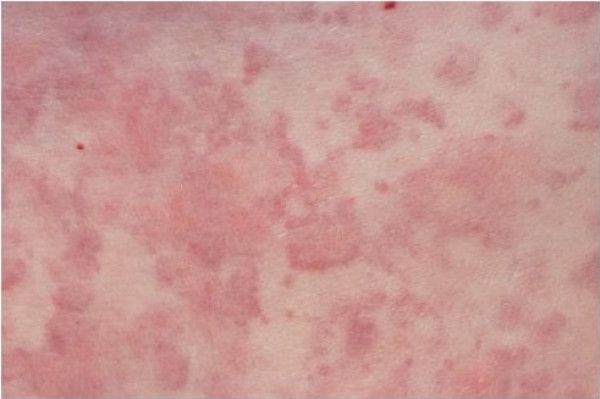
Urticarial rash at presentation.